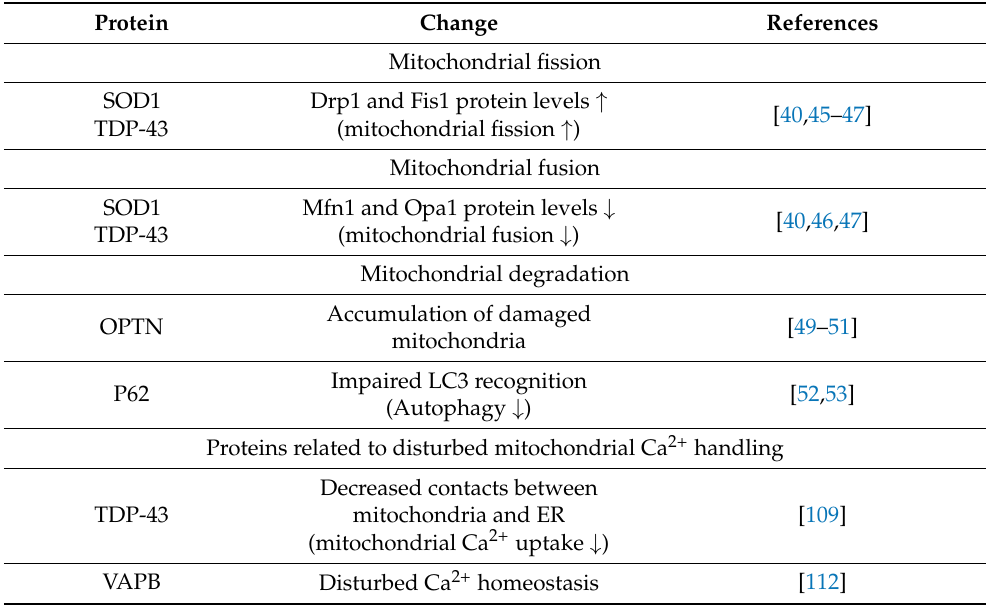
Table 1. Proteins associated with impaired mitochondrial dynamics in